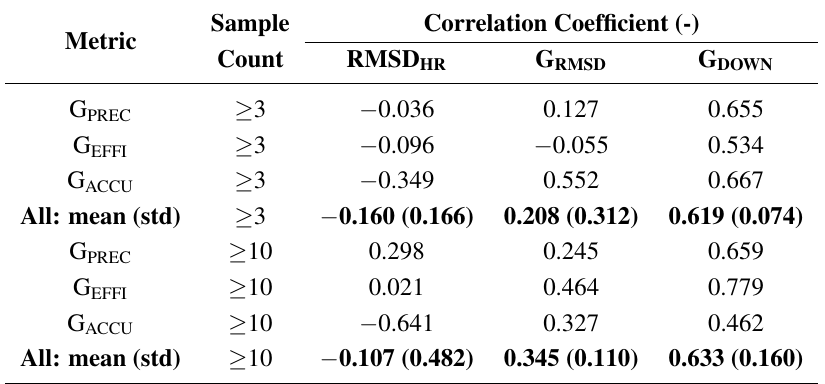
Table 4 summarizes the results for the three performance metrics: the traditional root mean square difference between disaggregated and in situ soil moisture (RMSD ), the disaggregation gain in RMSD HR relative to the non-disaggregation case (G ) and the proposed metric that combines the disaggregation RMSD gain in S, R and B relative to the non-disaggregation case (G ). The correlation coefficient DOWN